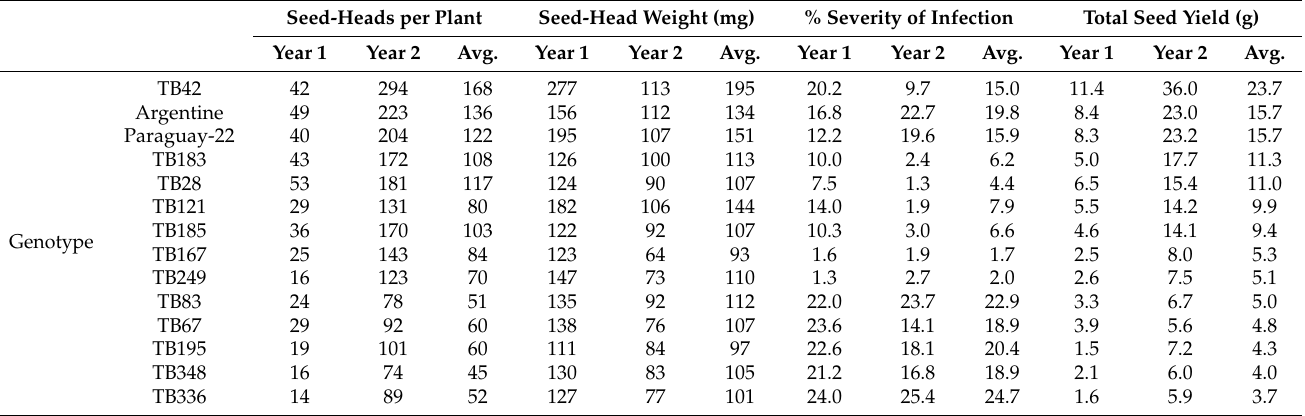
Table 1. Summary of data from the different traits measured in the field. Averages for genotypes, locations, and